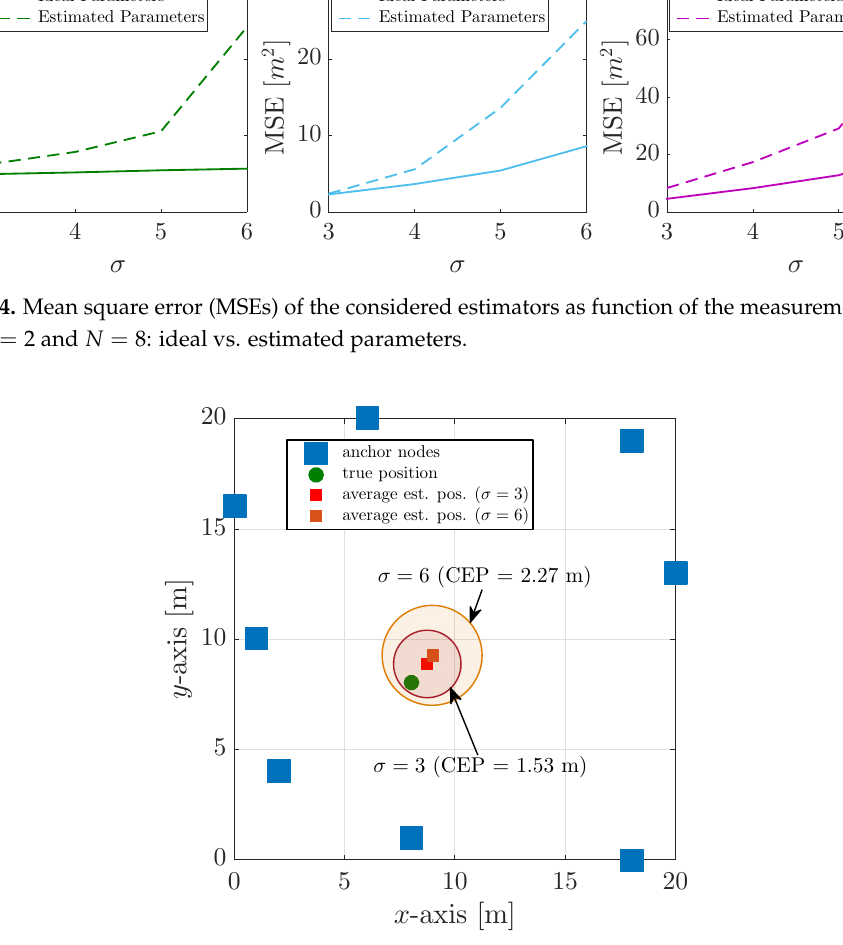
Figure 5. Graphical representation of the considered network for N = 8 and for a fixed target position. Shaded circles represent the circular error probable (CEP) of the proposed two-step localization approach for σ ∈ { 3,6 }